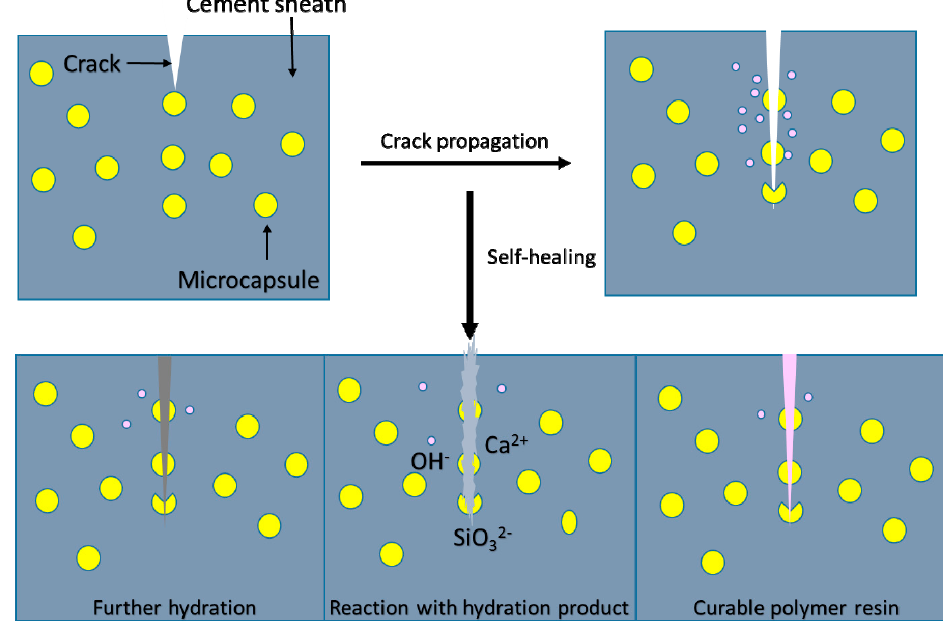
Figure 8. Self-healing mechanism of the cement sheath.